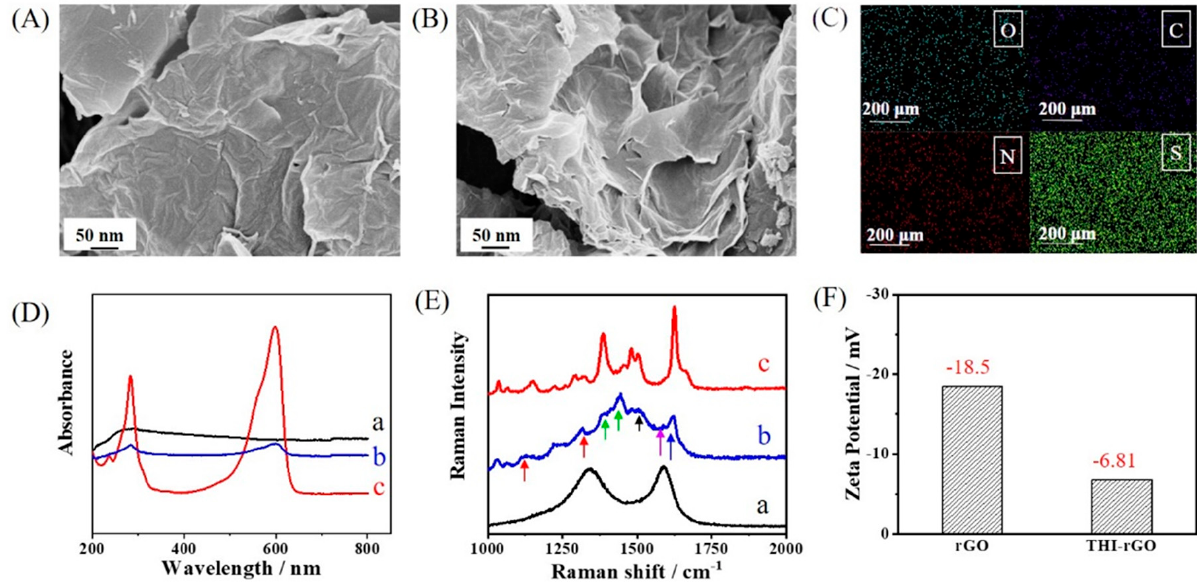
Figure 1. SEM characterization of ( A ) rGO and ( B ) THI-rGO. ( C ) Mapping images of THI-rGO. ( D ) UV-vis absorption spectra and ( E ) Raman spectra of (a) rGO, (b) THI-rGO and (c) THI. ( F ) Zeta potential of rGO and THI-rGO.